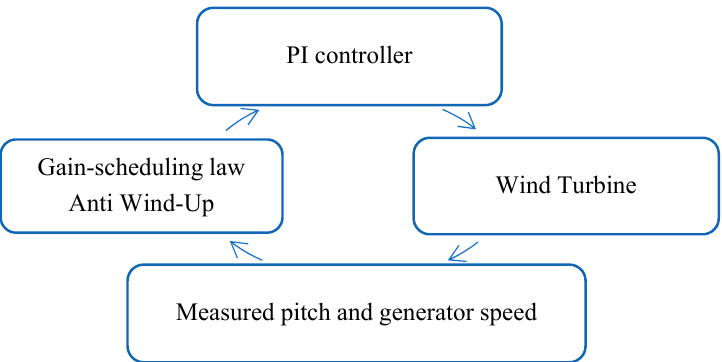
Figure 4. Simplified diagram for the improved PI scheme.